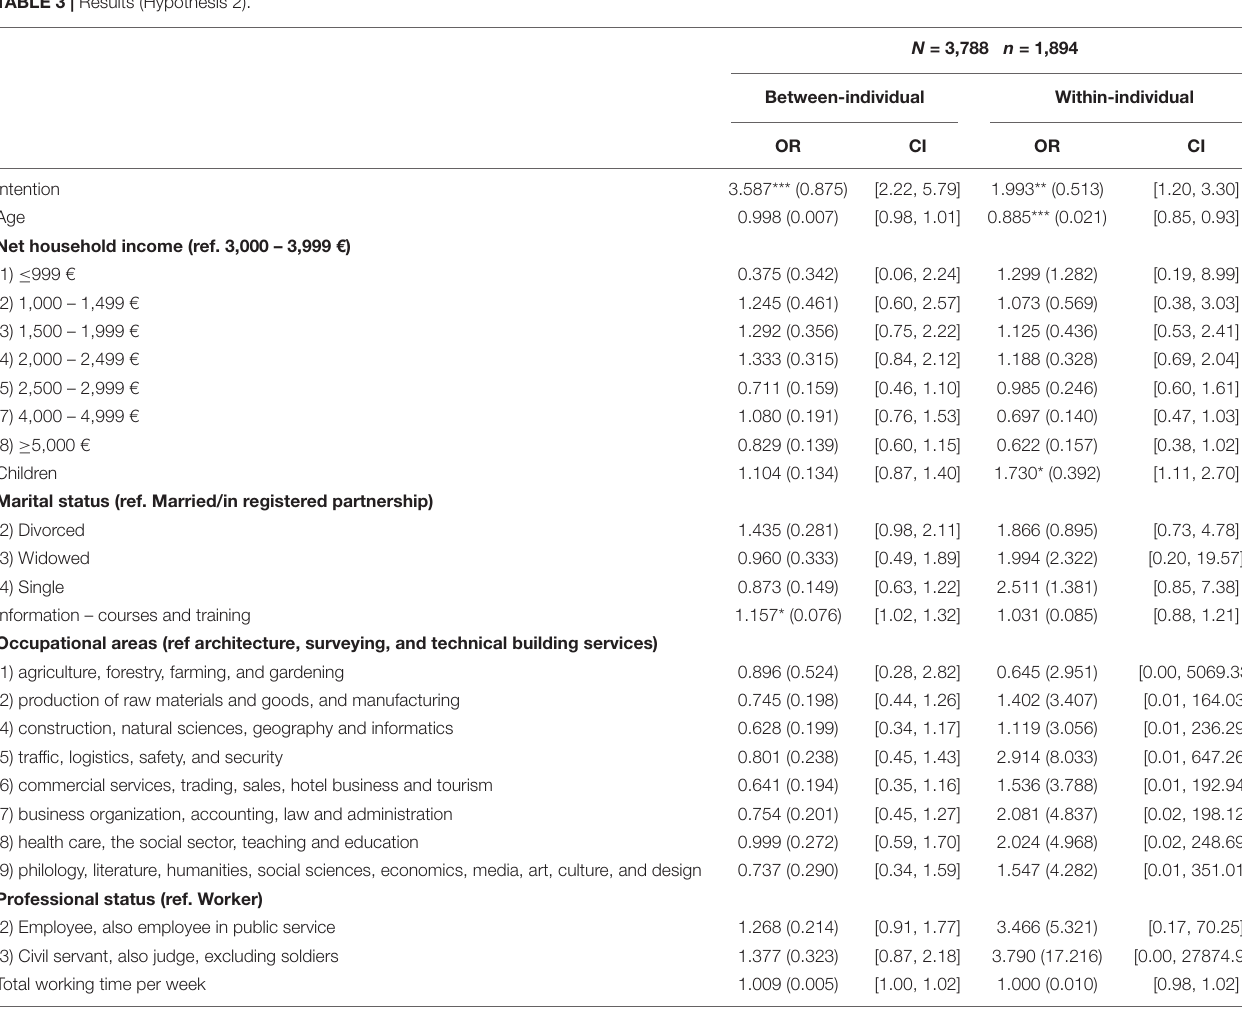
TABLE 3 | Results (Hypothesis